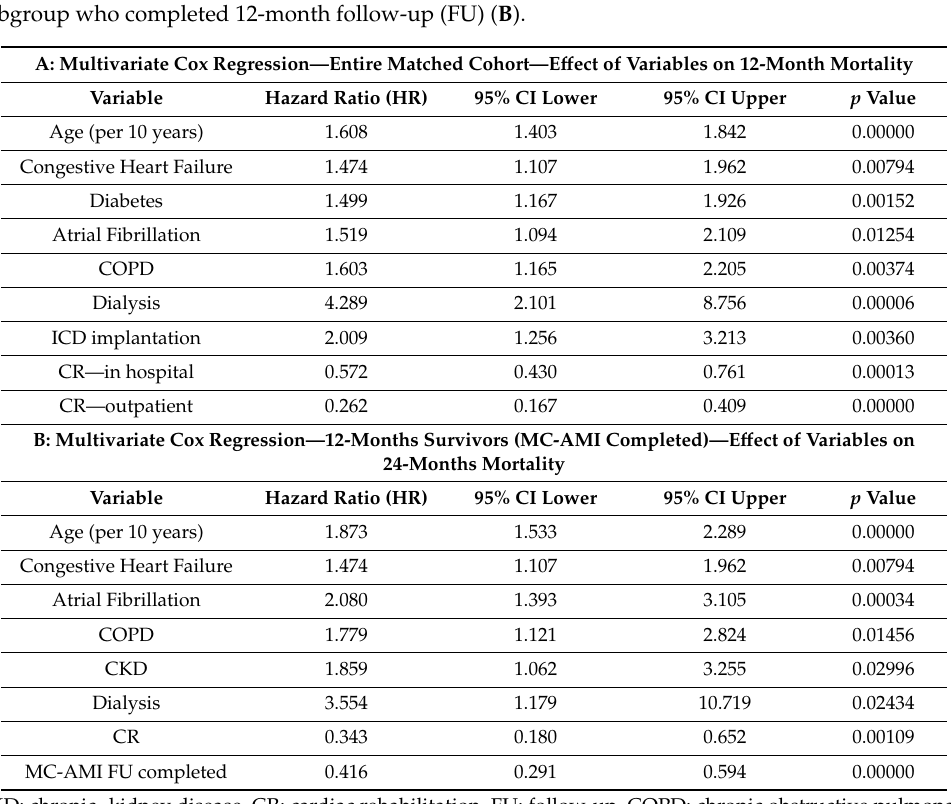
Table 5. E ff ect of MC-AMI interventions on mortality—Cox proportional hazards model—mortality in 12-month observation in the entire matched population ( A ) and 24-month mortality in the MC-AMI subgroup who completed 12-month follow-up (FU) ( B